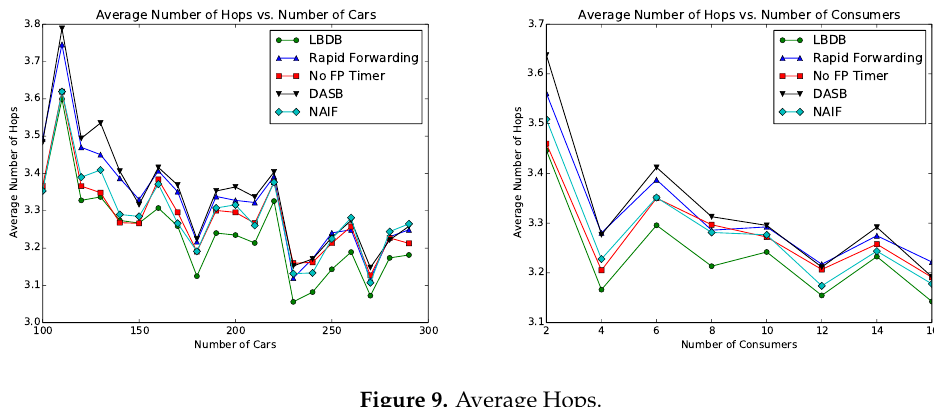
Figure 9. Average Hops.